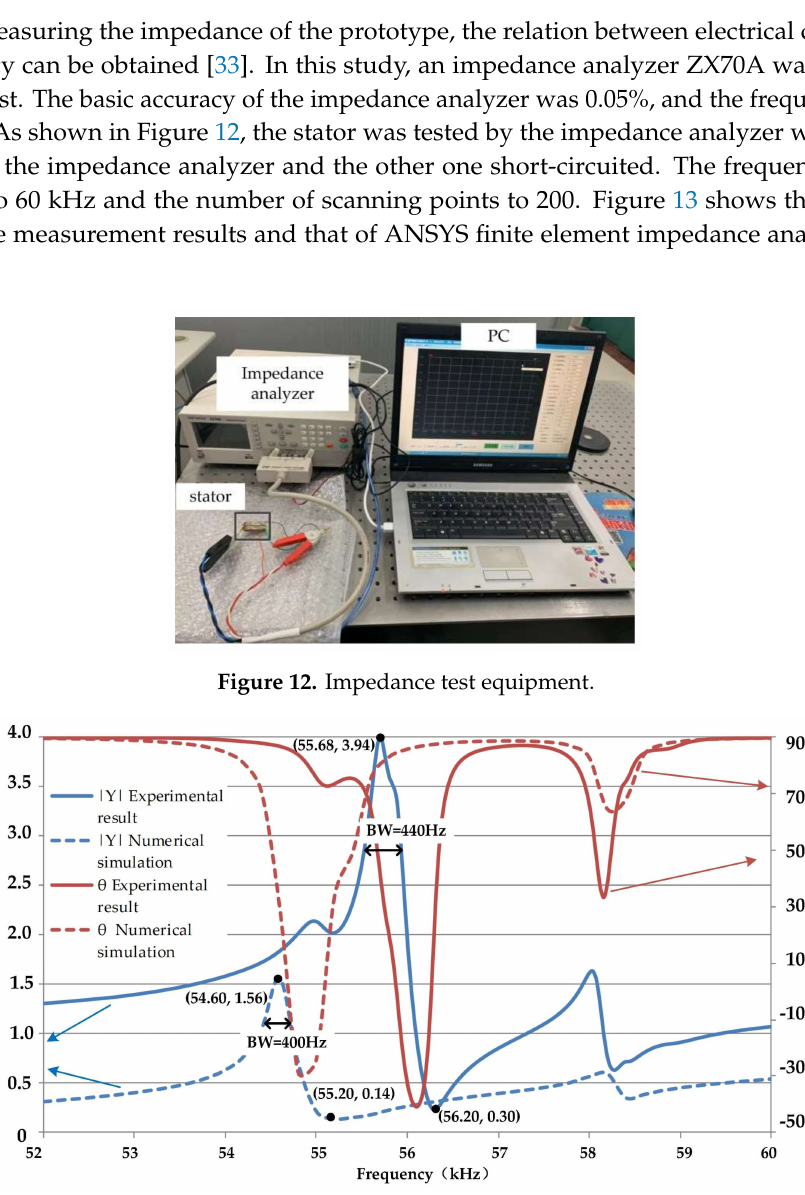
Figure 13. Data diagram of stator impedance